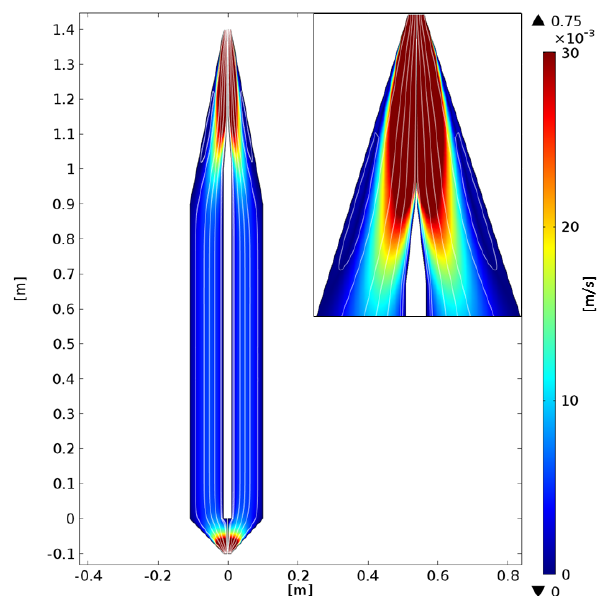
Figure 6. A 2-D cross section of the CLACE 2013 droplet evapo- ration unit showing the air streamlines and velocity field, calculated using Comsol 4.2a. An enlargement (not to scale) of the upper cone section of the evaporation unit is shown in the